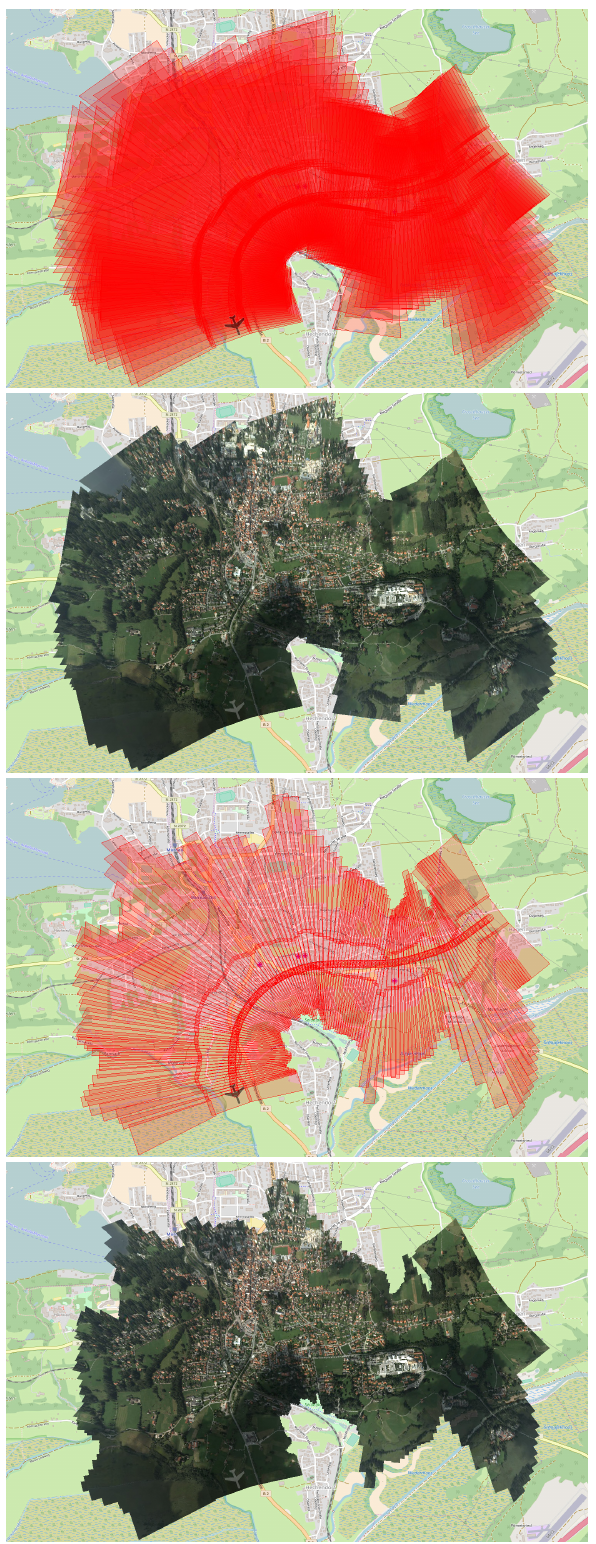
Figure 3. Map generation using TAC algorithm: Sample scene comprising 392 aerial images, captured by a triple sensor cam- era head. Full footprint rendering (upper images) and clipped images by TAC algorithm (lower images). By application of TAC algorithm, image data to be rendered was reduced by 86%